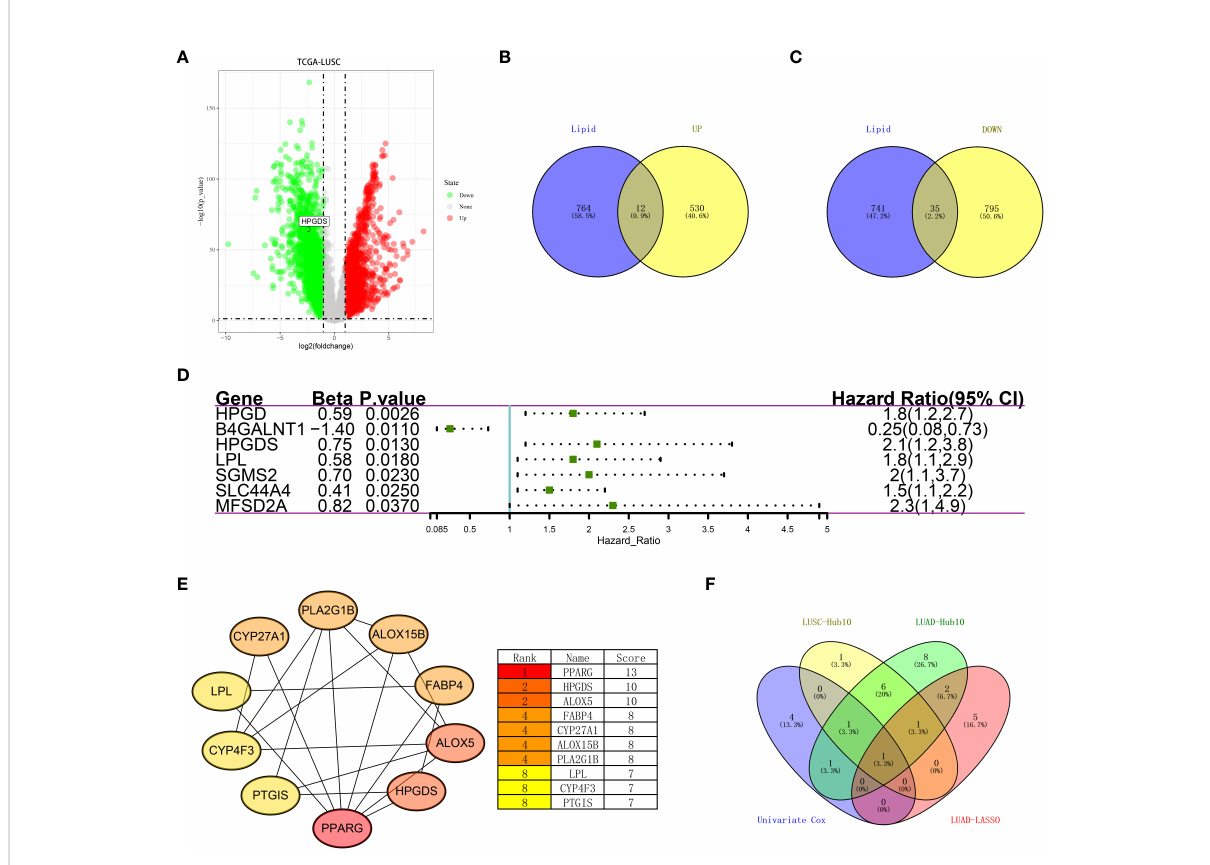
FIGURE 4 (A) Differentially expressed genes between LUSC and normal tissues in the TCGA dataset. (B) Upregulated lipid metabolism differential genes in tumor tissues. (C) Lipid metabolism differential genes downregulated in the tumor tissues. (D) Univariate COX analysis of key lipid metabolism